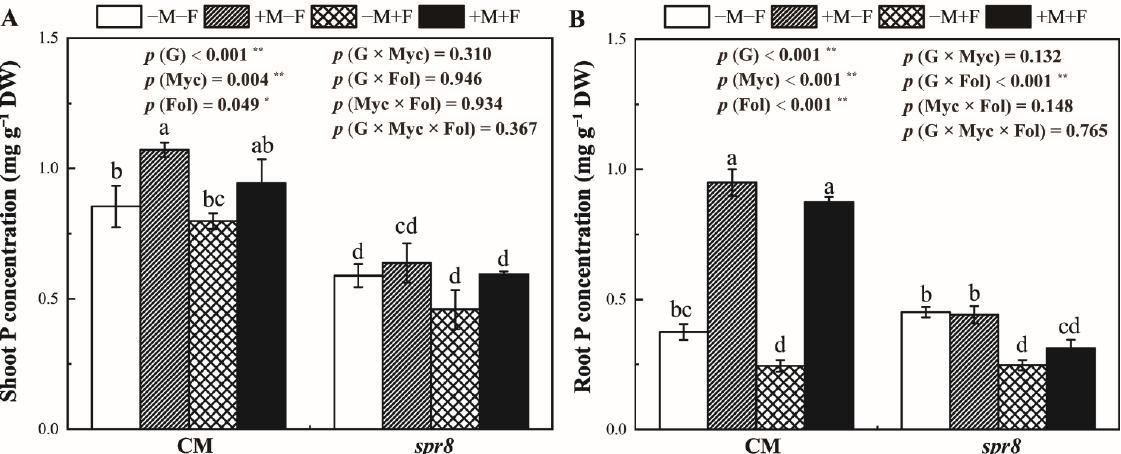
Figure 4. Effects of inoculation with Rhizophagus irregularis inoculation (Myc) and Fusarium oxysporum f. sp. Lycopersici (Fol) on the shoot ( A ) and root ( B ) P concentration of CM and spr8 plants (G). − M and +M represent non-inoculation and inoculation with Rhizophagus irregularis , respectively. − F and +F represent non-inoculation and inoculation with Fusarium oxysporum f. sp. Lycopersici , respectively. Same lowercase letters above the columns indicate non-significant difference ( p < 0.05) between corresponding treatments. *— p < 0.05; **— p < 0.01.